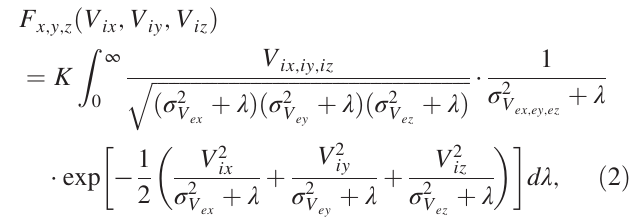
) caused by IBS for bench- s